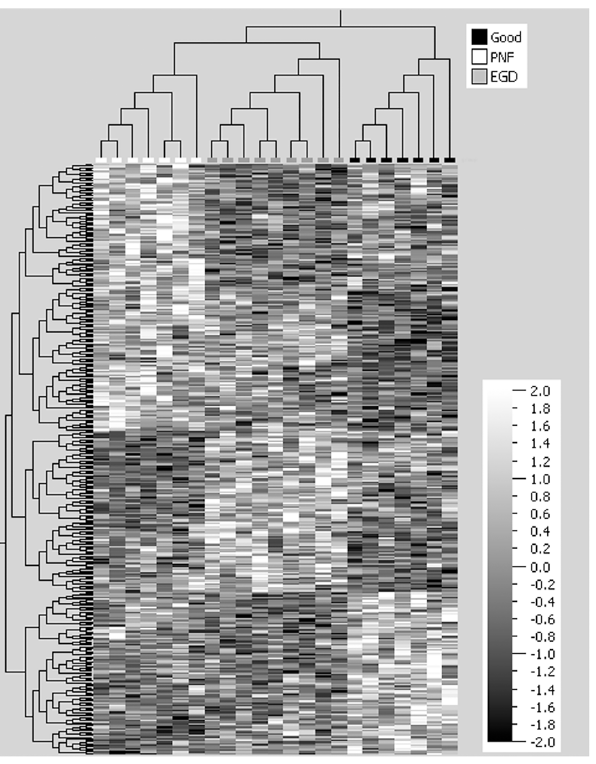
Fig 2. Heatmap of microRNA from the donation after cardiac death liver groups. microRNA (miRNA) was extracted from archival formalin fixed post-perfusion tru-cut donor liver biopsies taken from donation after cardiac death (DCD) livers of varying clinical outcome. DCD groups were categorized as primary non function (PNF) retransplanted within a week (n = 7), good functional outcome (n = 7) peak aspartate transaminase (AST) (cid:1) 1000 IU/L and early graft dysfunction (EGD) (n = 9) peak AST (cid:3) 2500 IU/L. The heatmap demonstrates miRNA differential expression between the three DCD liver groups of primary PNF, EGD and good (p < 0.05). Columns of the heatmap represent the different individual DCD liver biopsies and the horizontal cladogram at the top of the heatmap demonstrates clustering of samples according to DCD group of PNF, EGD and good. Key in top corner illustrates color labelling of DCD groups in the horizontal cladogram. The rows of the heatmap represent different miRNAs and the vertical cladogram shows clustering of miRNA species within each DCD group. The vertical graded scale shows that white within the heatmap represents increased expression and black decreased expression of a given miRNA. As no microRNA species was strongly associated with a given DCD clinical group, there is no clear heatmap pattern to be